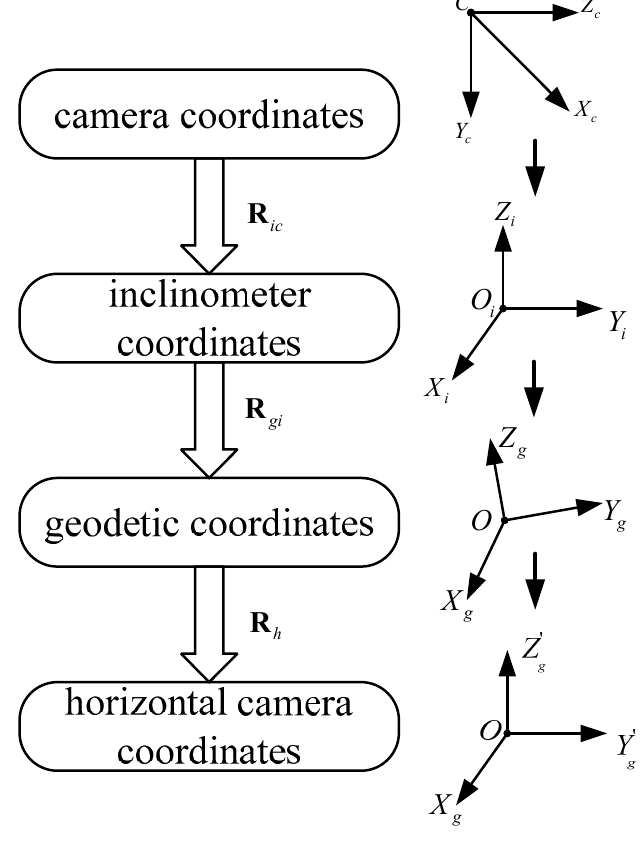
Figure 4. Flow chart of horizontal image correction.